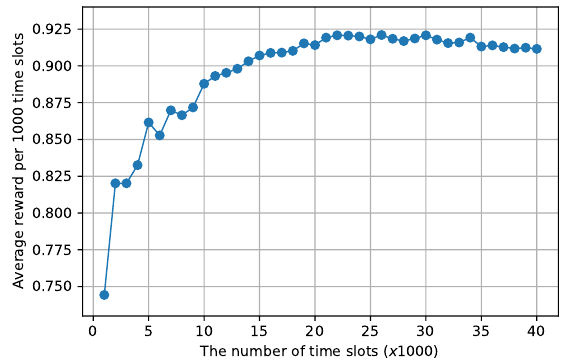
Figure 13. Actor–critic training convergence rate, e h , avg =